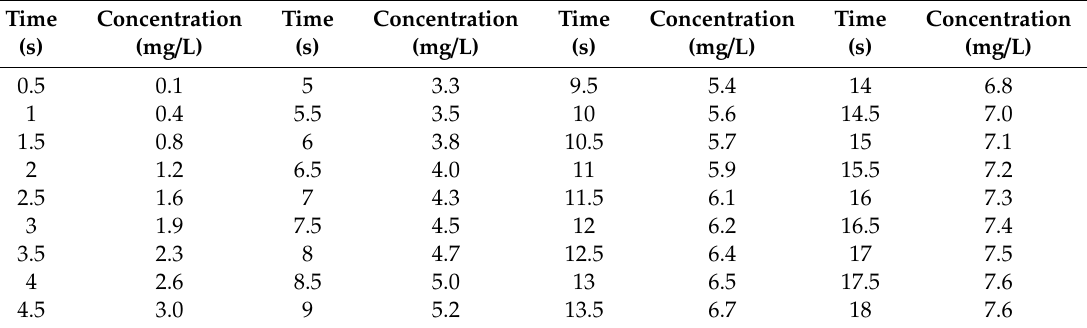
Table 3. Dissolved oxygen